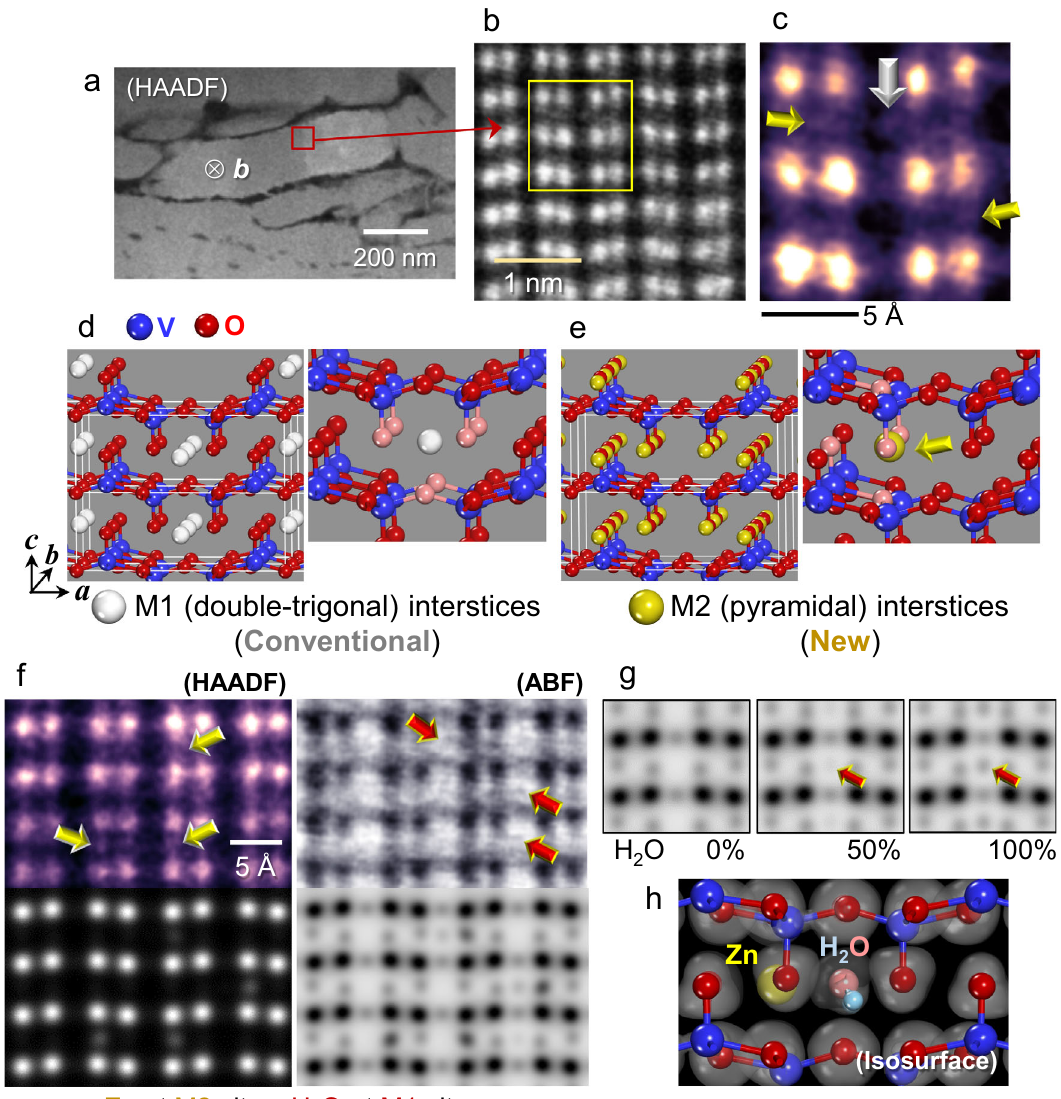
Fig. 3 Direct visualization of Zn and H 2 O insertion. a The HAADF image shows the polycrystalline microstructure of the discharged fi lm (0.77 V). b In addition to the V columns, another bright contrast is identi fi ed in this atomic-level image. A yellow rectangle indicates the typical location for the additional contrast between the V columns. c A magni fi ed image is provided for the location in b . Each of the white and yellow arrows indicates a detectable contrast from the two crystallographically distinct interstitial sites in V 2 O 5 . d , e The double-trigonal M1 and pyramidal M2 interstices are denoted by white and yellow spheres in the illustrations, respectively. Nearest-neighboring oxygens of each interstice are depicted by light-red spheres. f The yellow arrows verify the unconventional Zn occupancy at the M2 sites. While there is no bright contrast at the M1 sites in the HADDF image, a black contrast is clearly observed in the ABF image (red arrows). This reveals H 2 O insertion. The simulated images are in good agreement with the real images. g ABF image simulations with H 2 O occupancy demonstrate that visible contrast of H 2 O can be captured when the occupancy is ≥ 50%. h The isosurface contour of electron-density difference is illustrated with a H 2 O molecule as a ligand, demonstrating the stabilization of Zn at the M2 to 5 in each grain in Fig. 4c, d directly prove the multiphase ABF images obtained in the [001] projection are shown in transformation at a nanoscale. A detectable intensity is exhib- Supplementary Fig. 18 for better visualization of the presence of ited at many of the atomic columns for the pyramidal inter- H 2 O. stitial M2 sites in location 2, indicating a substantial amount of intercalated Zn in the Zn x V 2 O 5 phase. The most signi fi cant Multiple phase transformations . The key fi nding in this work observation from Fig. 5 is that the presence of intermediate states (VO 2 (A)-type and rocksalt VO-type structures), which was acquired when we examined the high Zn-concentration are very dif fi cult to detect by macroscopic powder diffraction, is regions near grain boundaries. Figure 5a, b show ADF images of clearly identi fi able at atomic resolution, as revealed in the V 2 O 5 grains in the b - and c -axis projection, respectively. The images for locations 3 − 5. The structure observed in location 3 magni fi ed regions with a high Zn concentration, as denoted by in both projections matches well with that of VO 2 (A) among a red rectangle in each projection, were scrutinized. Two series many polymorphisms found in VO 2 (see Supplementary Fig. 19 of atomic-column-resolved ADF images taken from locations 1